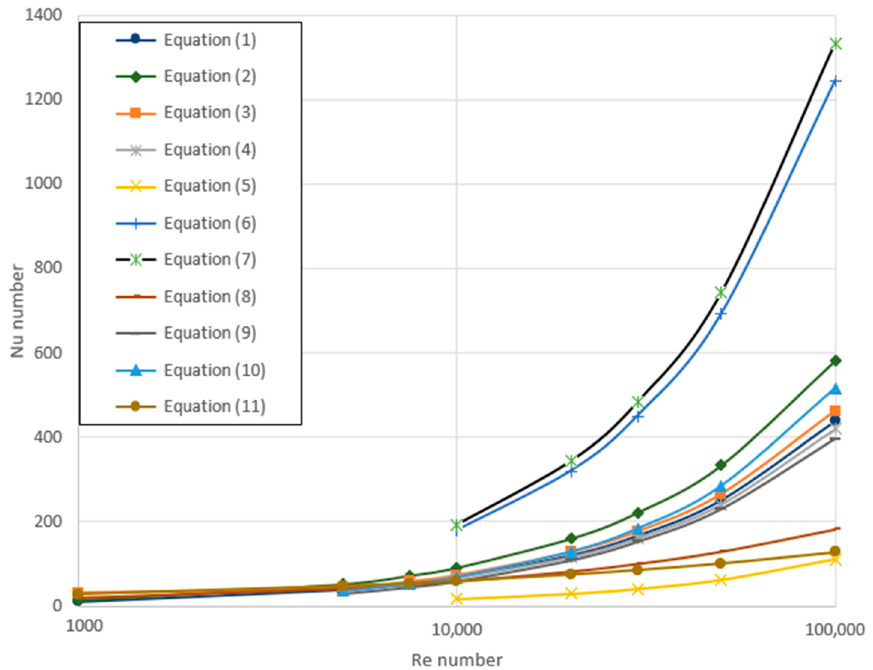
Figure 1. Nu-Re relationships for water. Table 3. Nu number correlation equations for water- Al 2 O 3